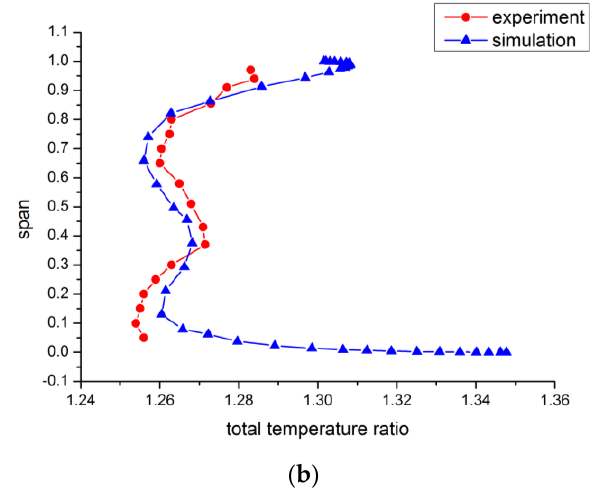
Figure 6. Span distribution of the total pressure ratio and total temperature ratio at the peak efficiency point ( a ) span distribution of the total pressure ratio at the peak efficiency point; ( b ) span distribution of the total temperature ratio at the peak efficiency point.